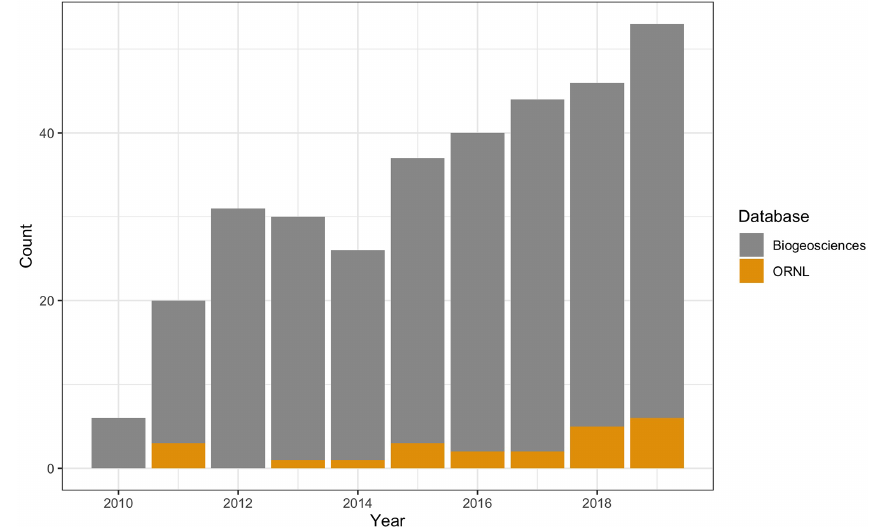
Figure 1. Summary of studies citing the global soil respiration database (SRDB) between 2010 and 2019. More and more studies are using SRDB since the first version (SRDB-V1) was published (Bond-Lamberty and Thomson, 2010a).